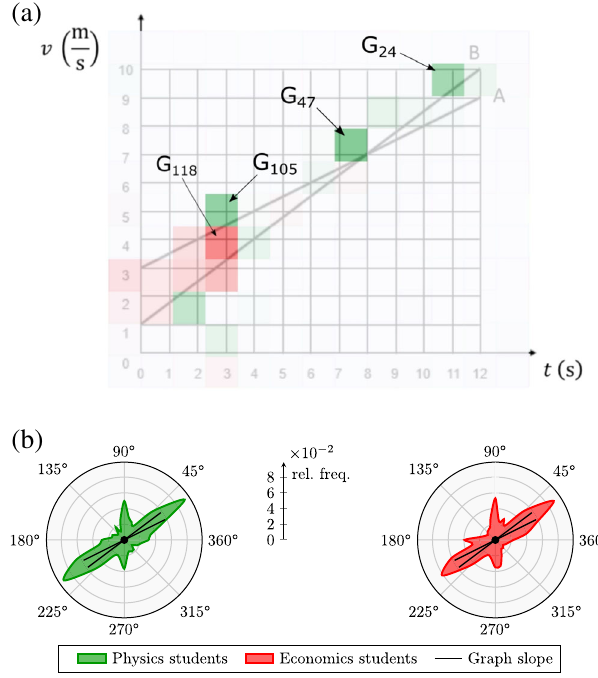
FIG. 8. Analysis of visual attention and saccadic eye